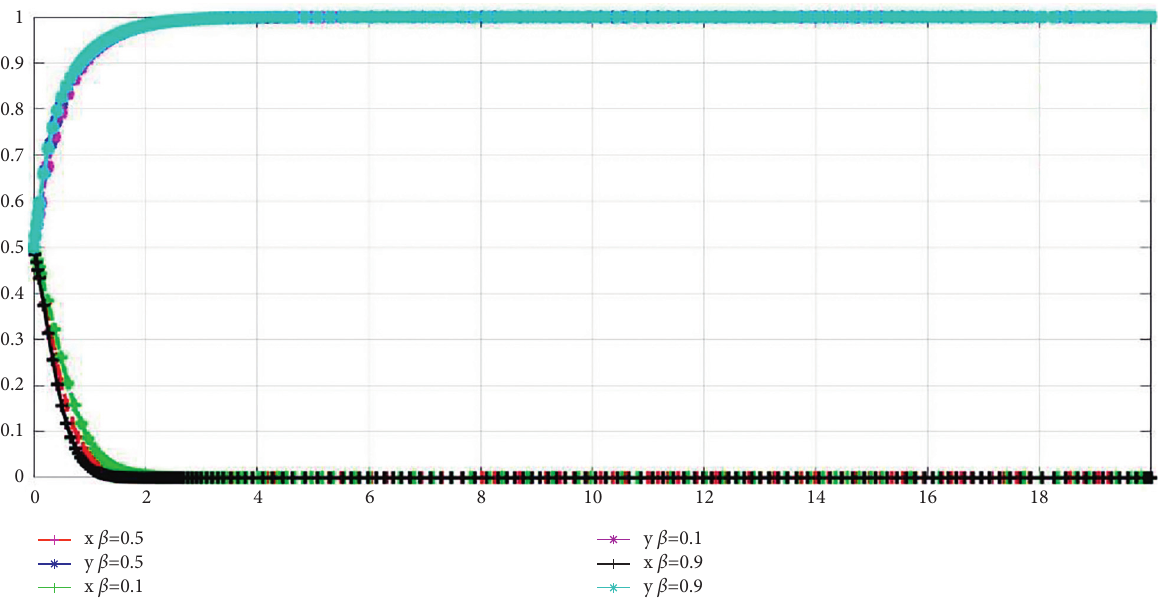
Figure 7: Evolution track of different demand-oriented policy